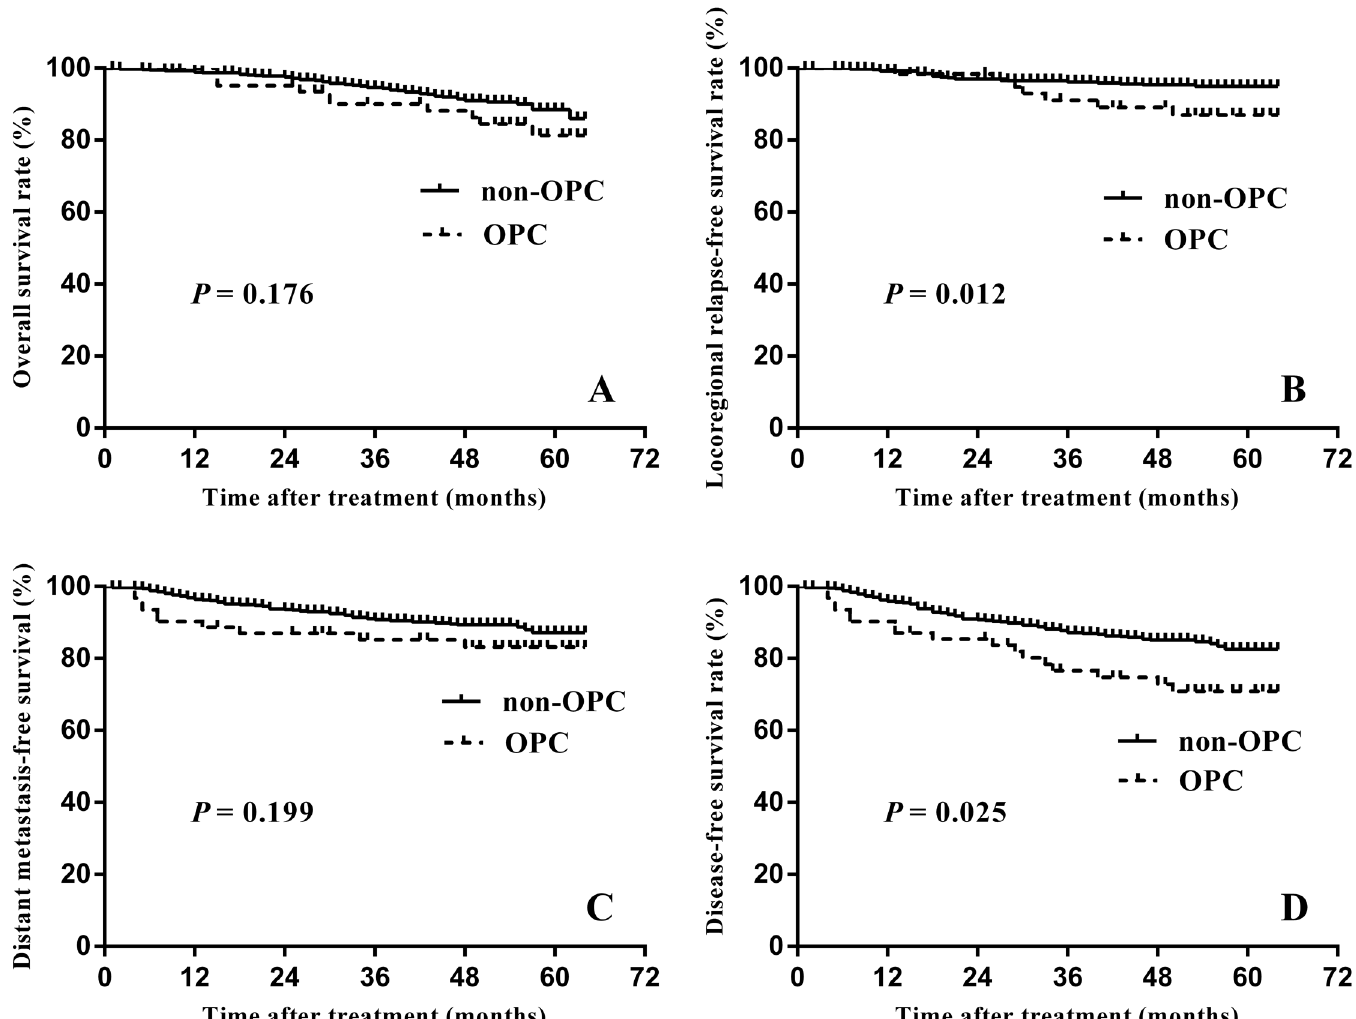
Fig 2. Comparisons of the overall survival. (A), locoregional relapse-freesurvival (B), distant metastasis-free survival (C) and disease-free survival (D) for nasopharyngeal carcinomapatients with non-OPC vs. OPC.